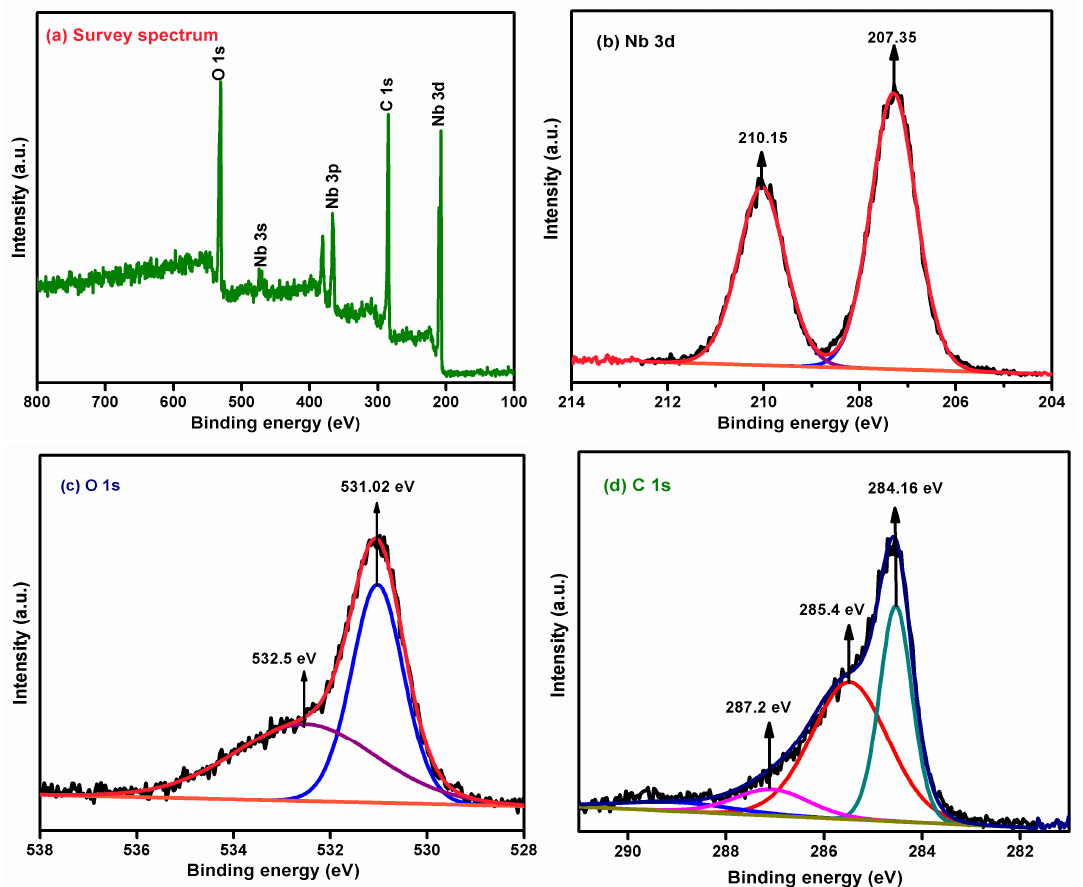
Figure 7. Display (XPS) the survey spectra of Nb 2 O 5 /G nanocomposite.